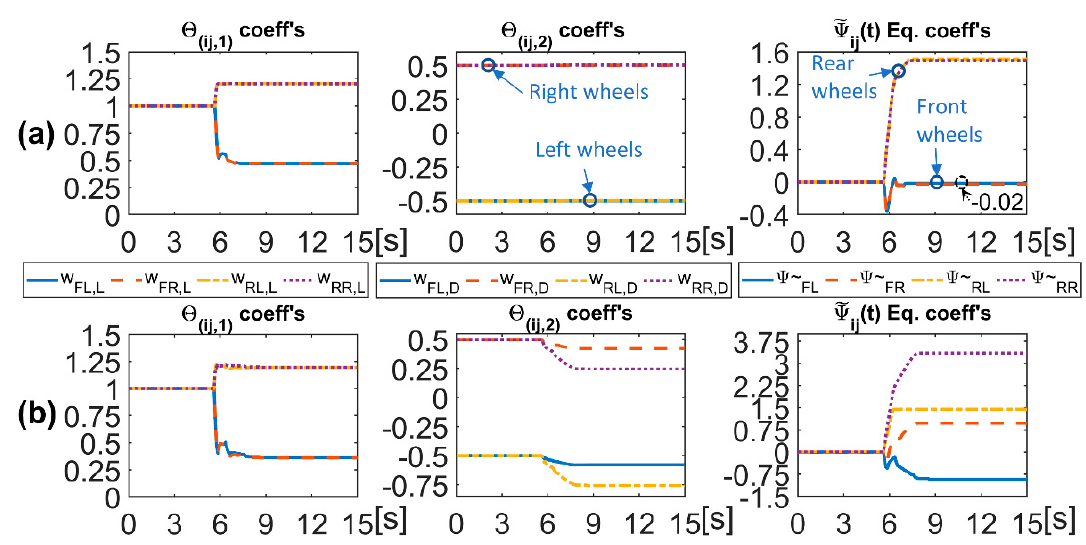
Figure 18. SV Equalization: Pseudoinverse matrix Θ ( ij ,1 − 2 ) (32), (cid:101) Ψ ij (33) equalization coefficients: ( a ) Centre “heavy” extra-load (first-row); ( b ) RL “light”, RR “heavy” extra-load (second-row).